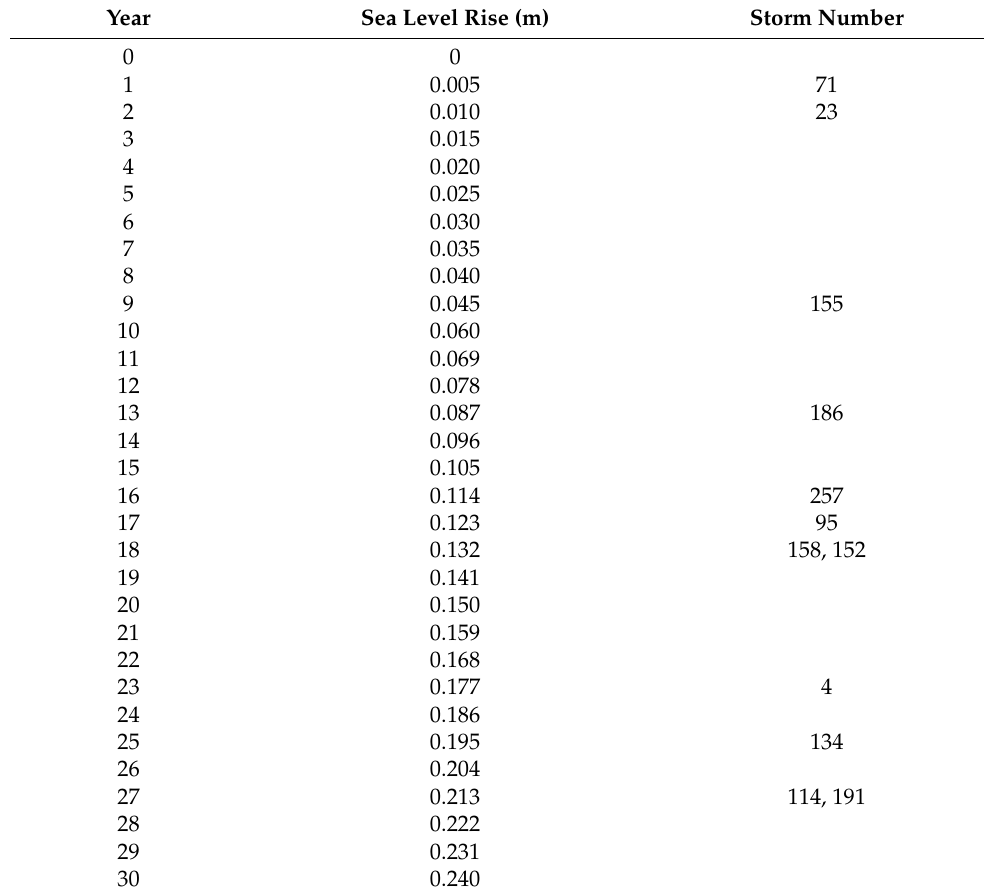
Table 1. Thirty-year climatology including a moderate amount of sea level rise (SLR) and synthetic storm